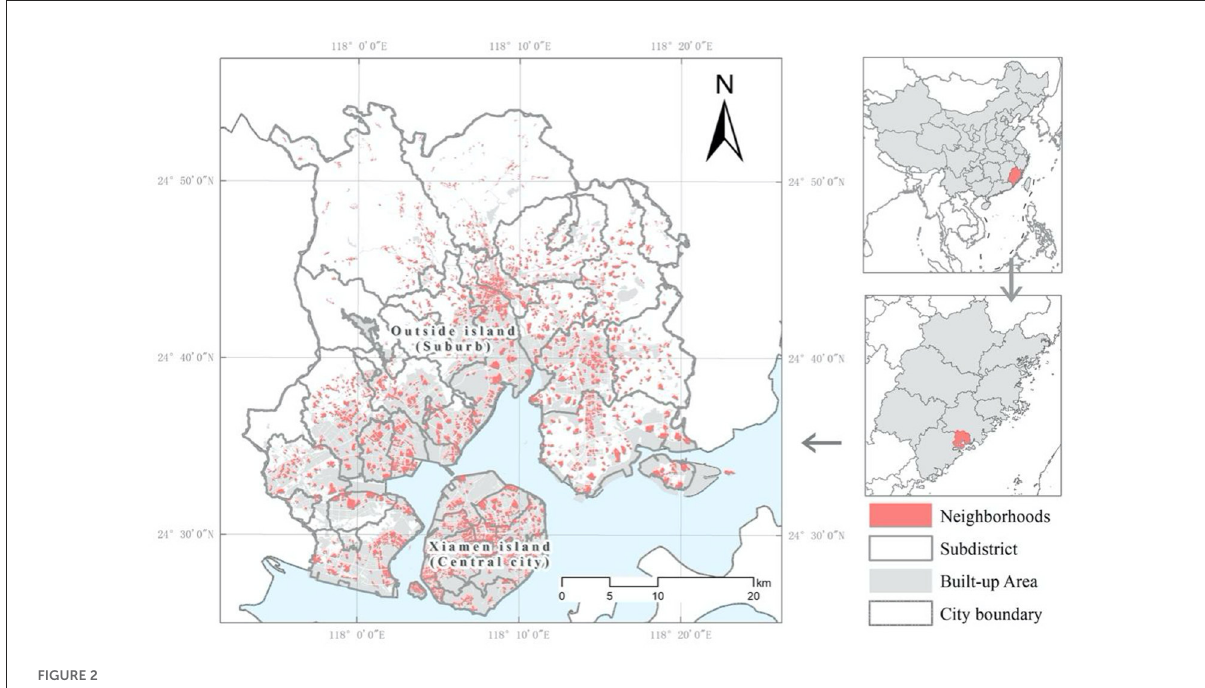
(https://doi.org/10.6084/m9.figshare.21524391). A